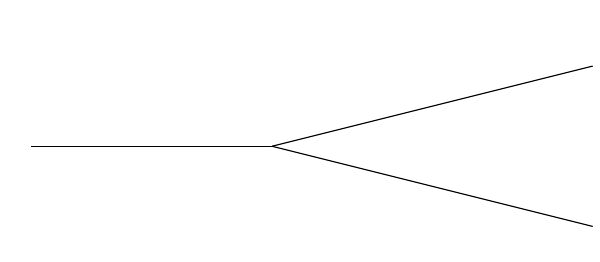
Figure 8: A 1-dimensional manifold which is Hausdorff, but not locally Euclidean at the point of